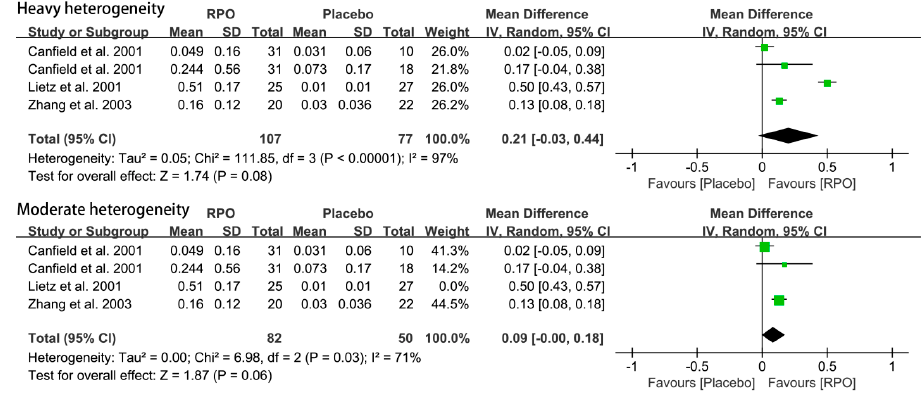
Figure 6. Forest plot of the effect of red palm oil (RPO) intervention on serum α -carotene levels ( μ mol/L) (RPO group vs. placebo group). CI: confidence interval.